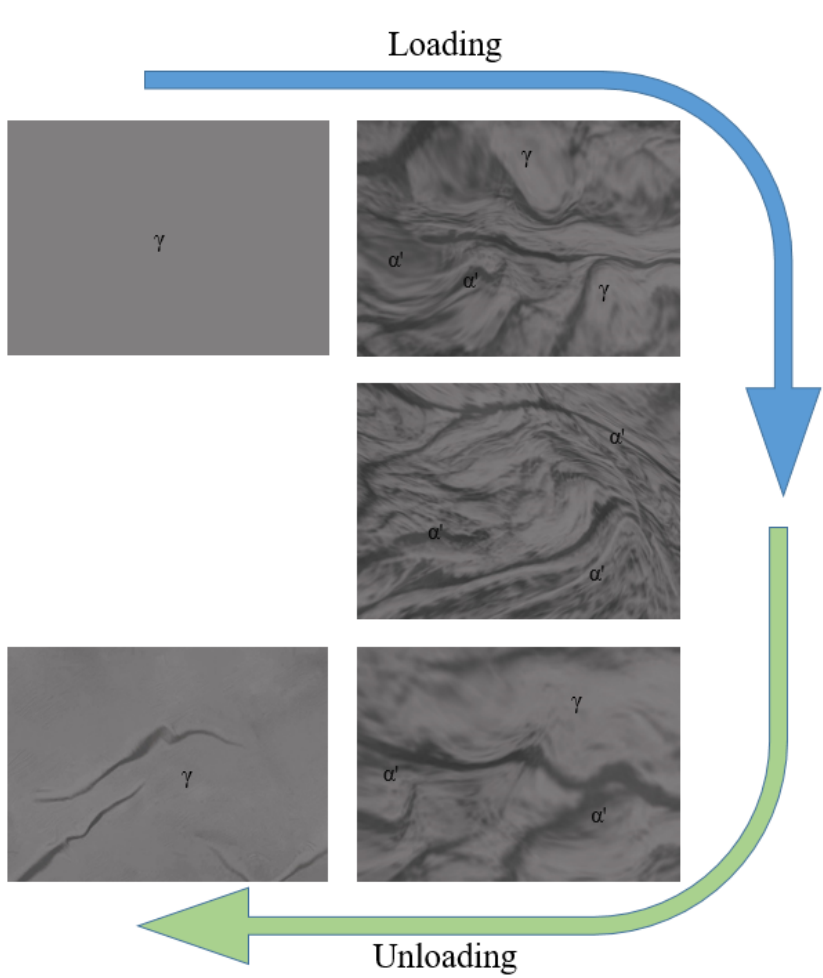
Figure 2. A schematic diagram of stress-induced martensitic transformation ( γ refers to the parent phase, and α ' refers to martensite).